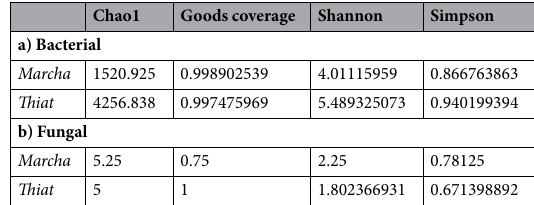
Table 1. Alpha diversity estimation. Non parametric alpha diversity was calculated for ethnic amylolytic starter cultures marcha and thiat